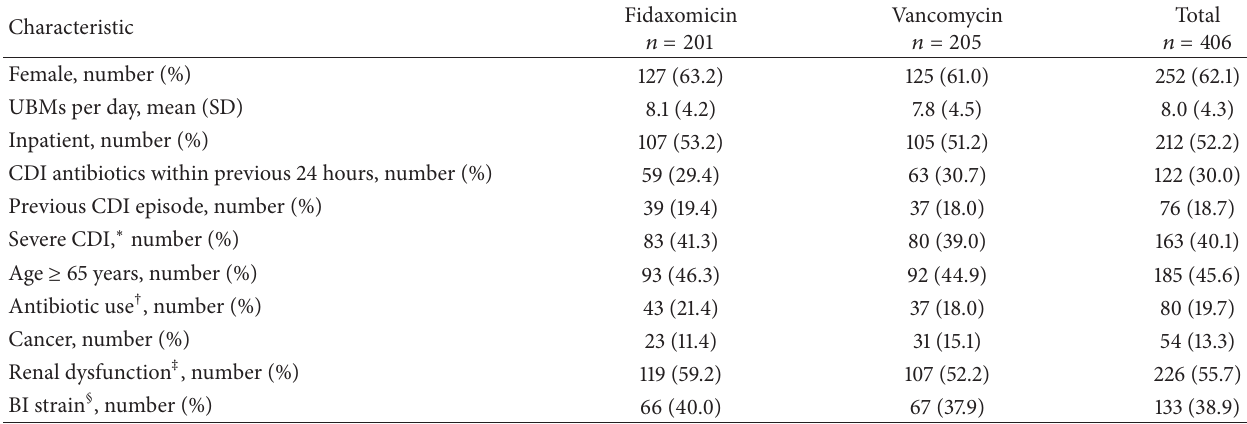
Table 1: Patient and disease characteristics within the mITT population.